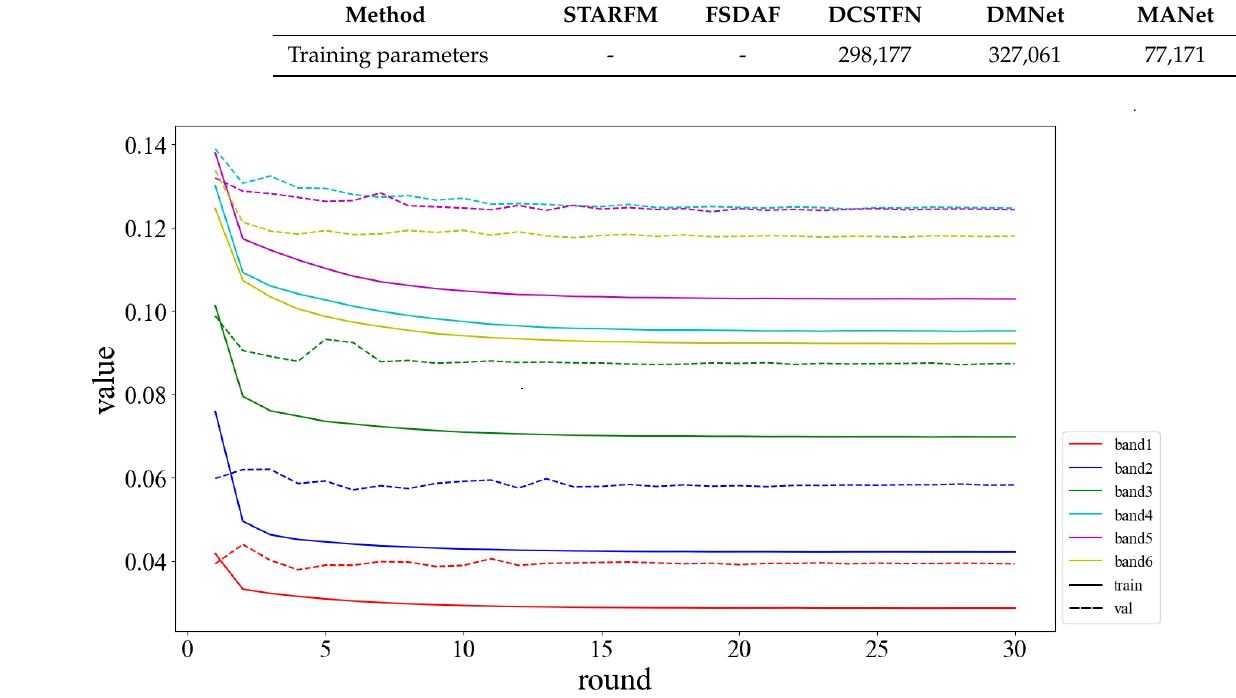
Table 4. The number of training parameters for various fusion methods.